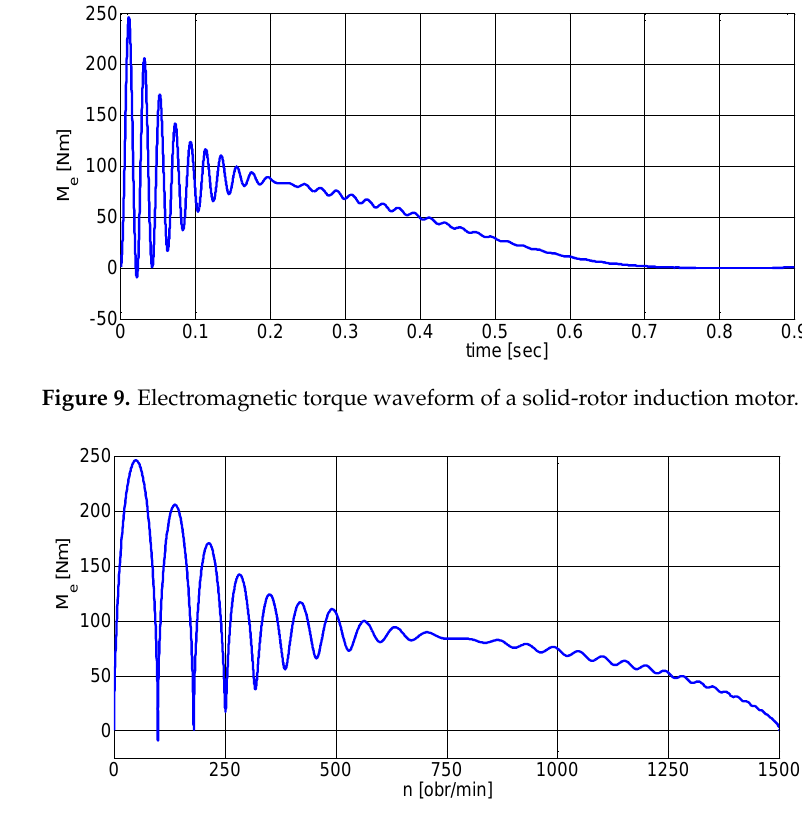
Figure 10. Torque–speed M e ( n ) trajectory of a solid-rotor induction motor during the Figure 10. Torque – speed M e ( n ) trajectory of a solid-rotor induction motor during the start-up. On the other hand, Figure 11 shows the torque – speed trajectory M e ( n ) during the reversion of the motor for the load torque M m = 0 and the moment of inertia J = 20 J N .